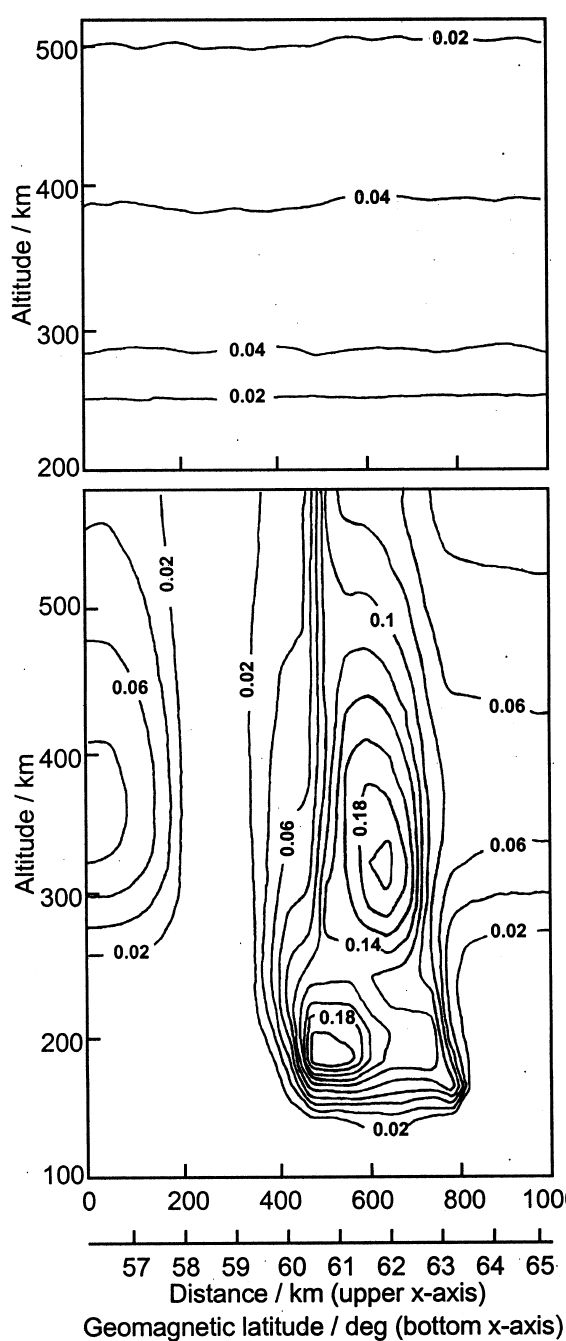
Fig. 4. Model electron density patterns ( × 10 12 m − 3 ) simulating the tomographic image of Fig. 3. The top panel presents the model pattern obtained without taking into account the electric field and precipitation of soft electrons. The bottom panel shows the model pattern simulated assuming an electric field with a latitudinal varia- tion and a flux of soft electron